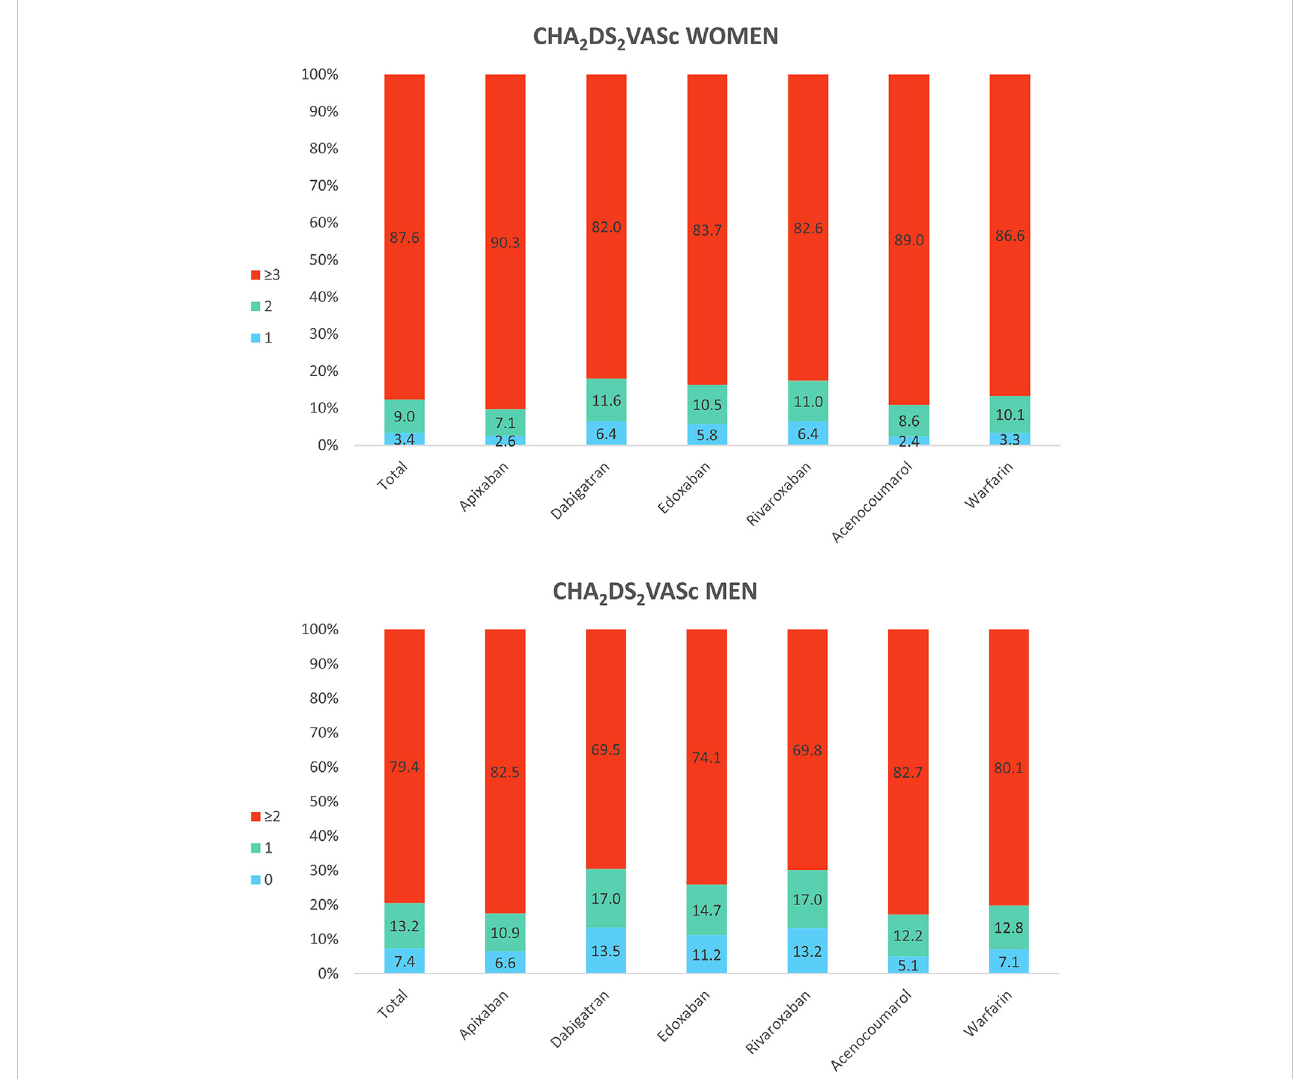
FIGURE 2 Baseline CHA 2 DS 2 VASc in women and men treated with oral anticoagulants. The top of Figure 2 shows theCHA 2 DS 2 VASc scores in all women receiving anticoagulants and by substance: 1, 2 and ≥ 3. The bottom shows the CHA 2 DS 2 VASc scores in all men receiving anticoagulants and by substance: 0, 1 and ≥